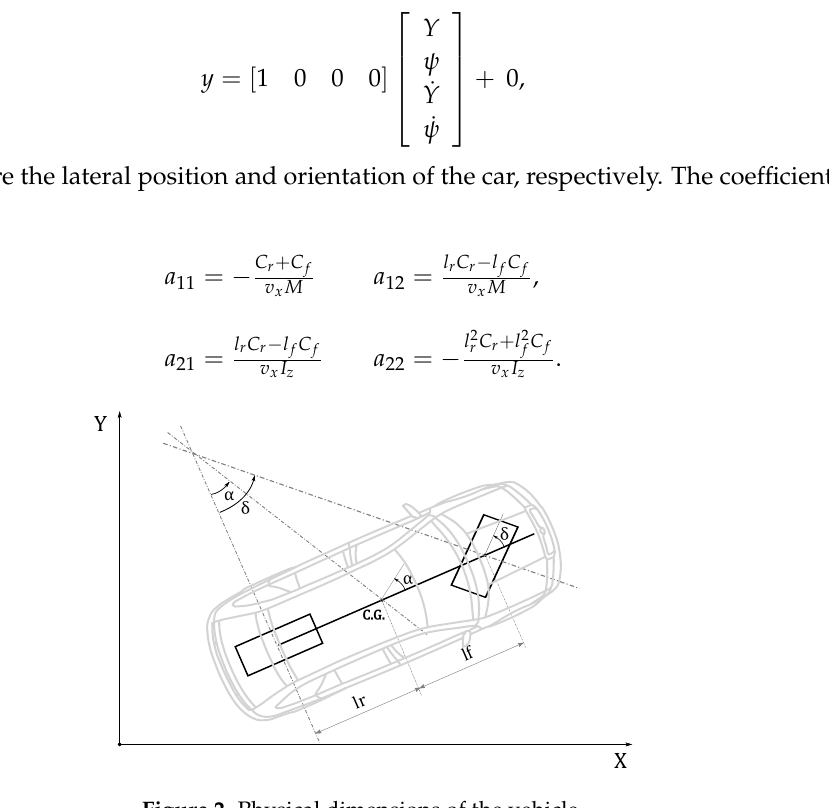
Figure 2. Physical dimensions of the vehicle.